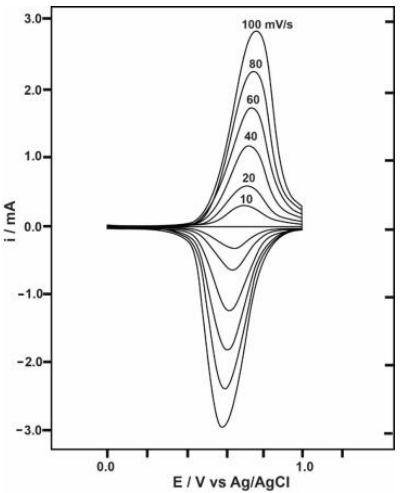
Figure 6. Cyclic voltammograms of a poly( N -phenyl-1-naphthylamine) film on Pt in 1 M LiClO 4 /CH 3 CN Figure solution at different scanning rates. Reprinted with permission from [85]. Copyright 1990, American Chemical Society.